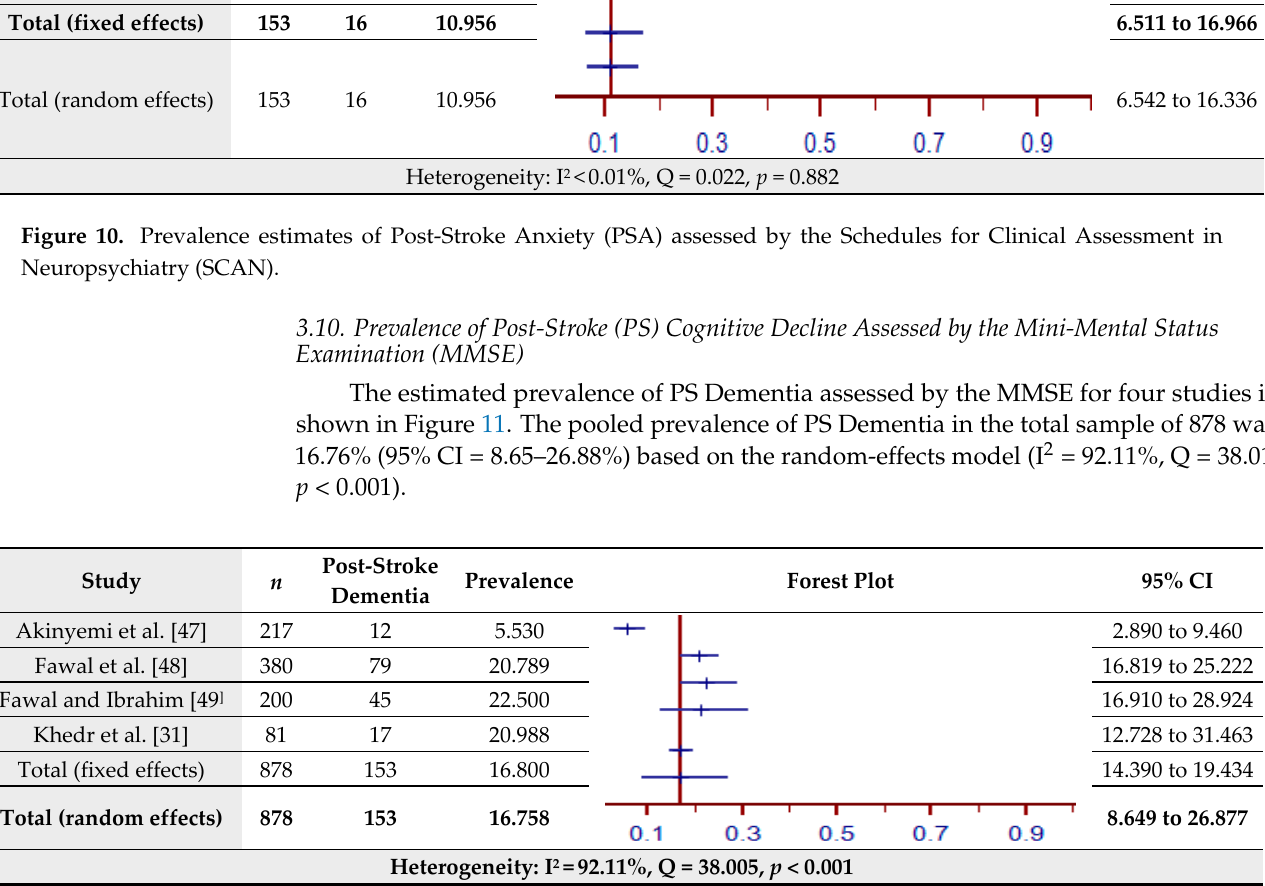
Figure 11. Prevalence estimates of post-stroke cognitive decline assessed by the Mini-Mental Status Examination (MMSE).